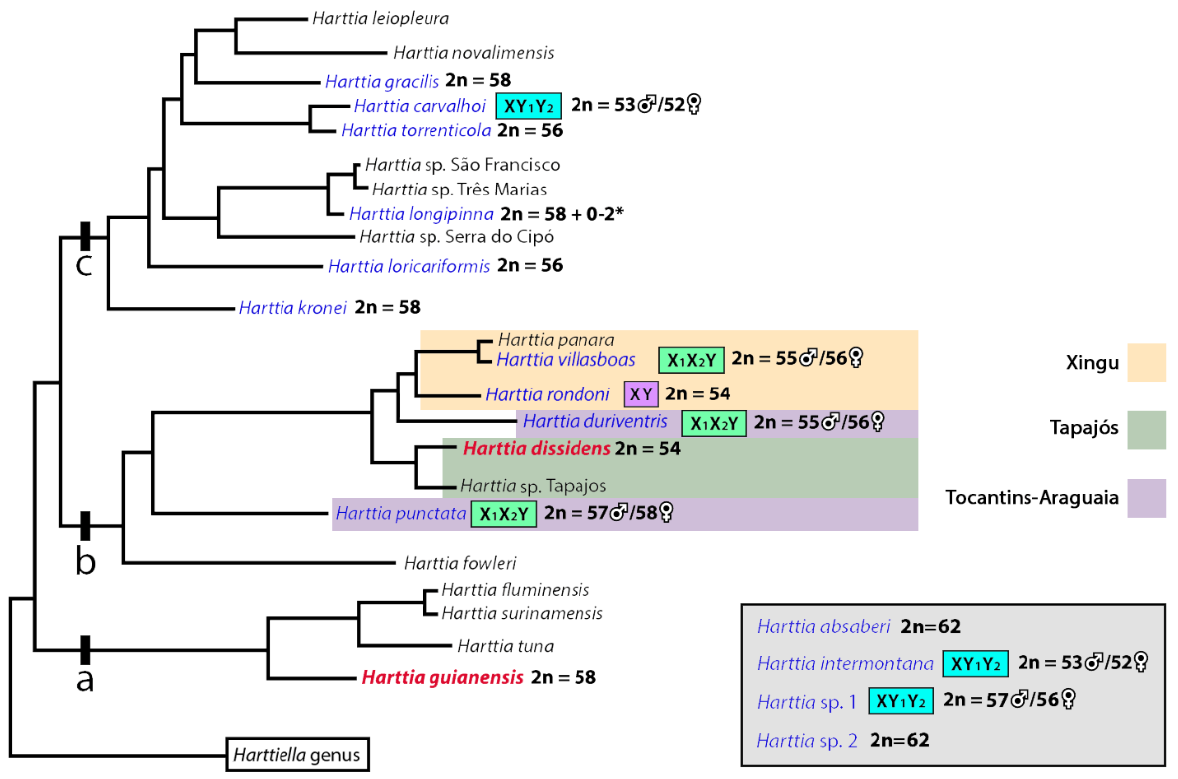
Figure 7. Updated schematic representation of the phylogenetic relationships between Harttia species (modified from our formerly published scheme—see ref. [36], based on the molecular data (see ref. [52]), and with plotted cytogenetic characteristics based on previous cytogenetic studies (blue), and the present study (red). Differentiated sex chromosomes are indicated in boxes as follows: X 1 X 2 Y (green box), XY 1 Y 2 (light blue box), and XY (pink box). Species listed in the gray box (placed at the bottom-right corner) were cytogenetically investigated but their position in the phylogenetic reconstruction needs yet to be determined. River basins where norther Harttia species occur are highlighted as follows: Xingu (yellow), Tapajós (green), and Tocantins-Araguaia (purple). Asterisks correspond to extra B chromosomes that can be found in H. longipinna karyotype [82].